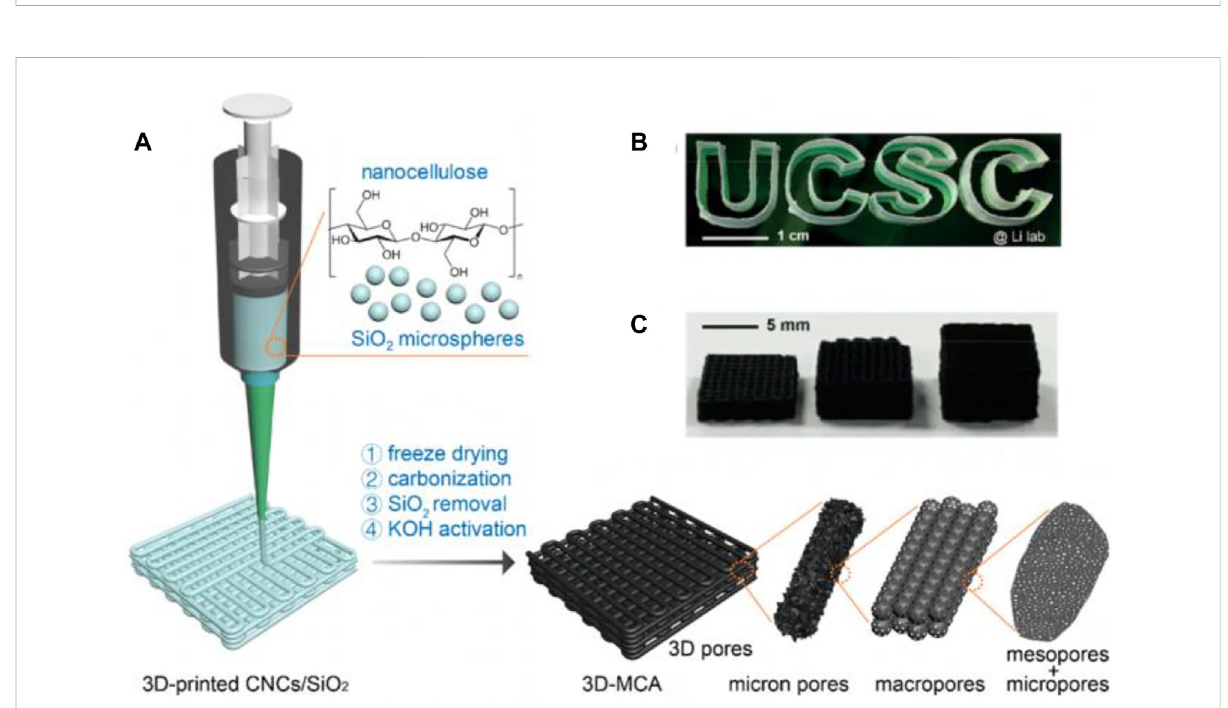
FIGURE 18 (A) Schematic illustration of the fabrication of 3D-printed multiscale porous carbon aerogels. (B) Digital image of the 3D-printed CNCs/SiO 2 aerogels with a shape of “ UCSC. ” (C) Digital image of the 3D-printed multiscale porous carbon aerogels with different thicknesses (Yao et al.,